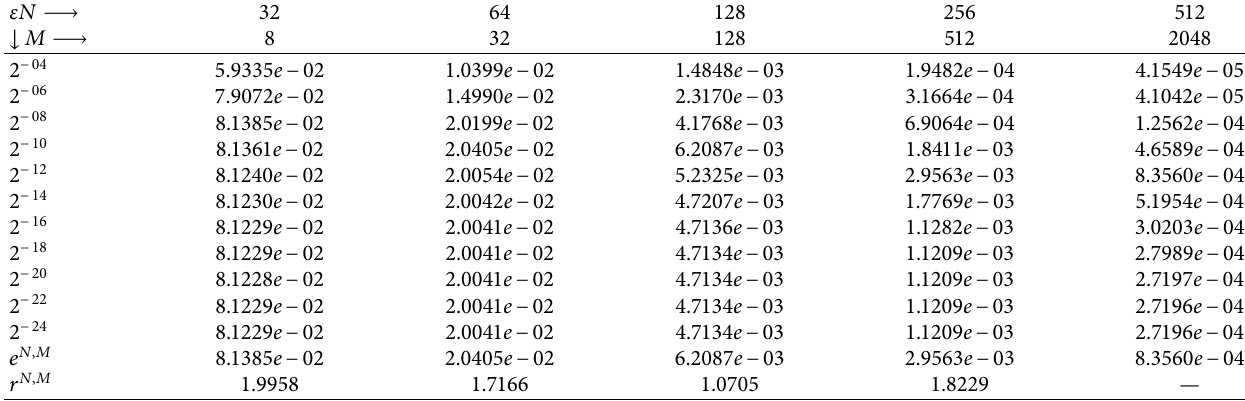
Table 1: Maximum absolute error and rate of convergence for Example 1.